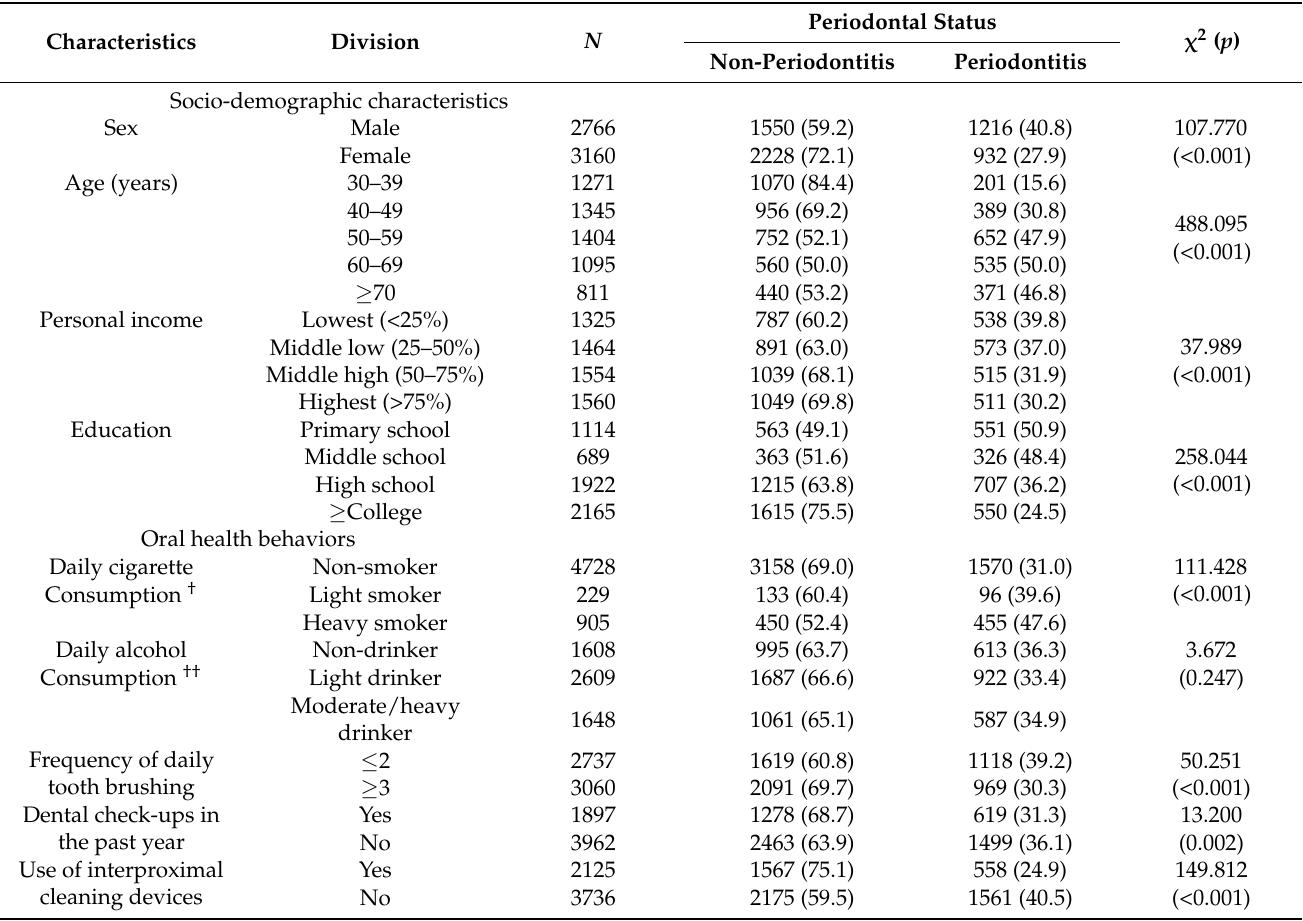
Table 1. Association between sociodemographic characteristics or oral health behaviors and